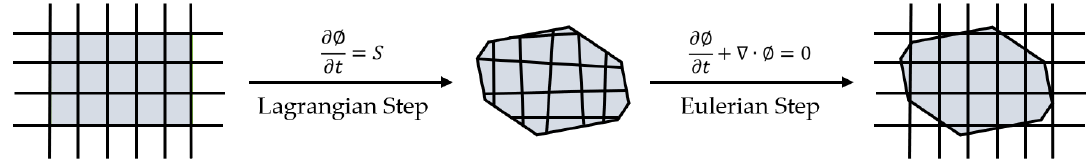
Figure 2. Schematic representation of operator split method adapted from [22].